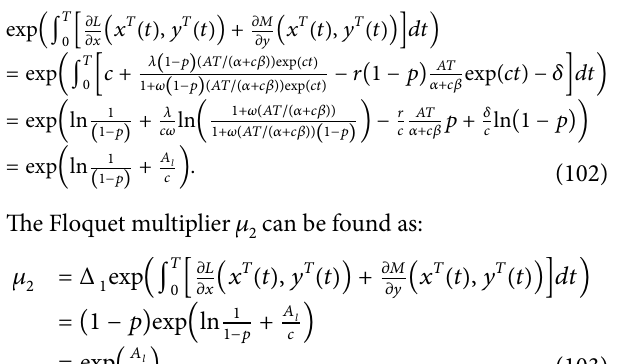
; (d–f) stable , , 푞 = 1.3 푐 = 1.8